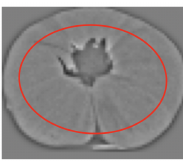
Figure 18. Area from which relevant points are obtained.